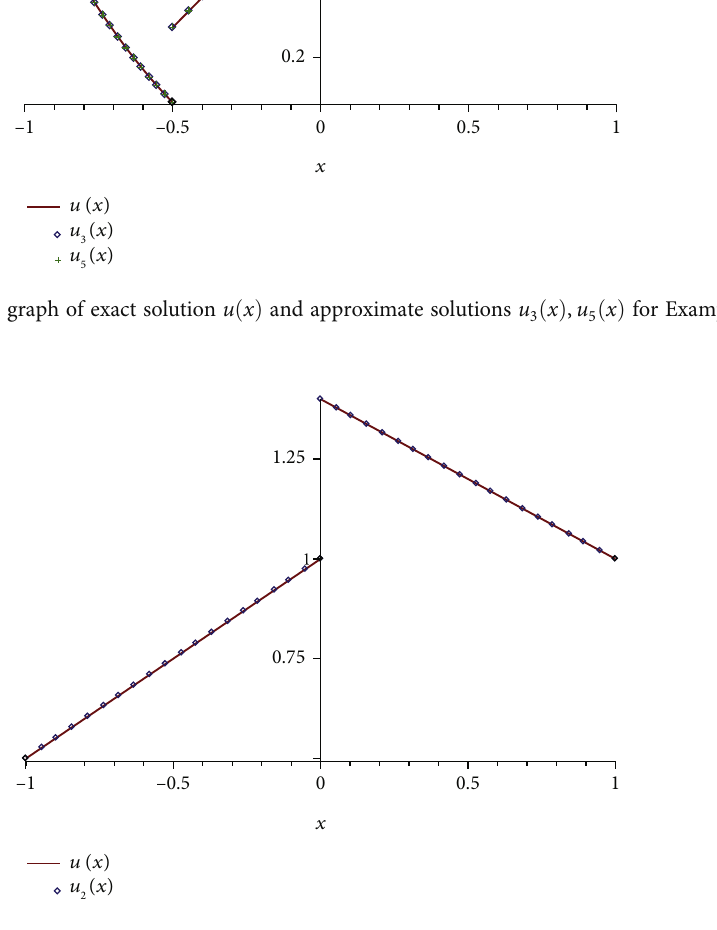
Figure 3: The graph of exact solution u ð x Þ approximate solution u